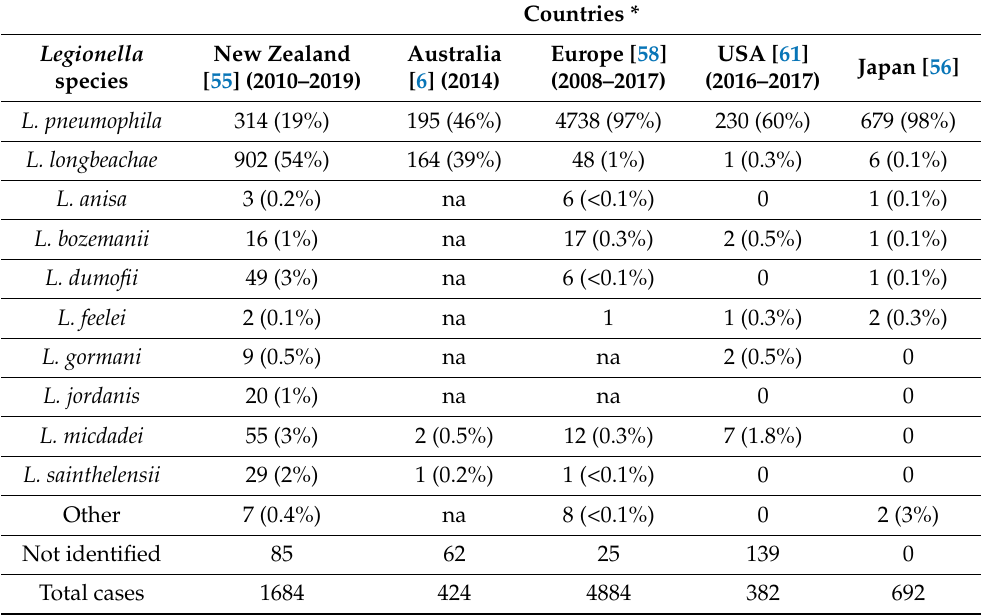
Table 1. Number of cases of Legionellosis reported from countries with national surveillance